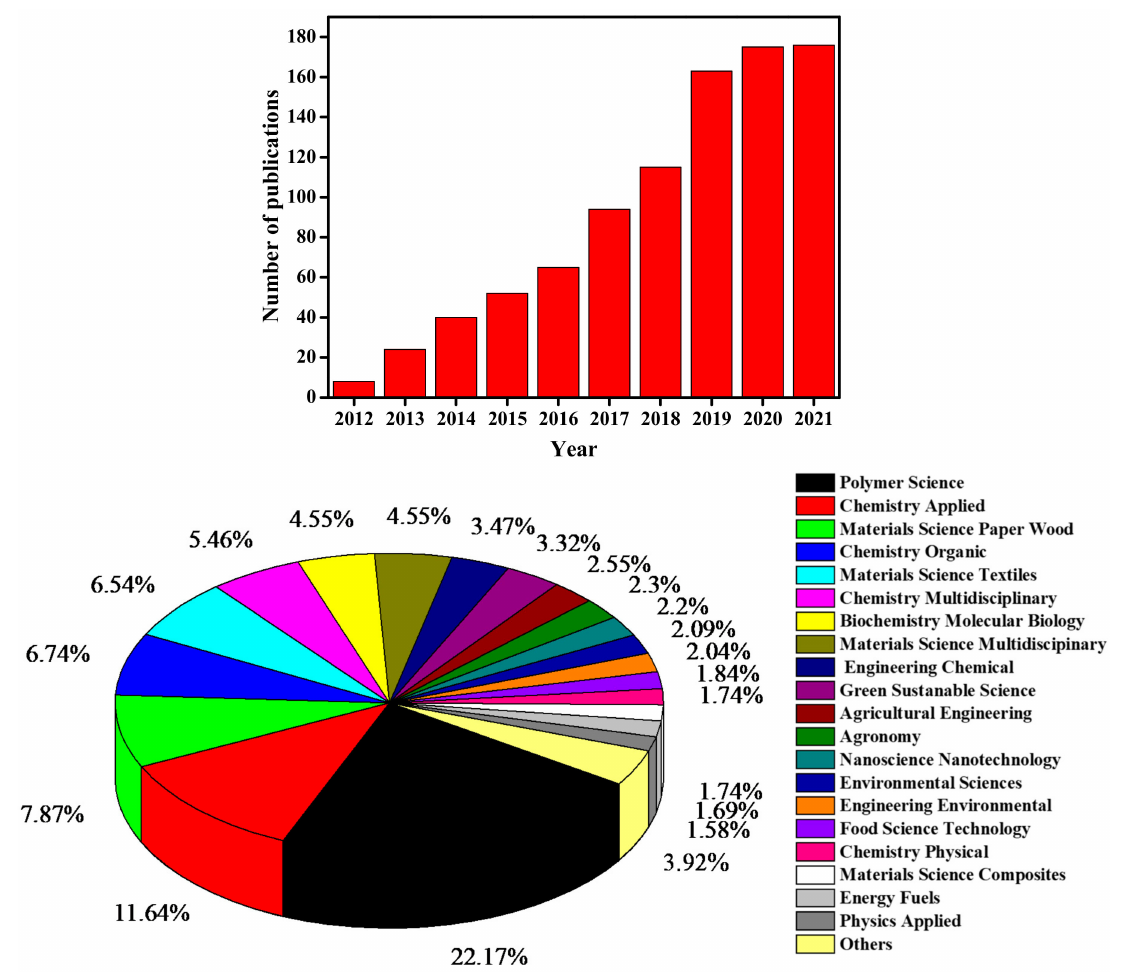
Figure 2. The histogram (top) depicts the number of publications containing “extraction of cellulose nanocrystals” from 2012 to 2021, obtained from the Web of Science in February 2022. The pie chart (bottom) depicts the number of publications (percentage per research field) mentioning “extraction of cellulose nanocrystals” from 2012 to 2021, obtained from the Web of Science in February